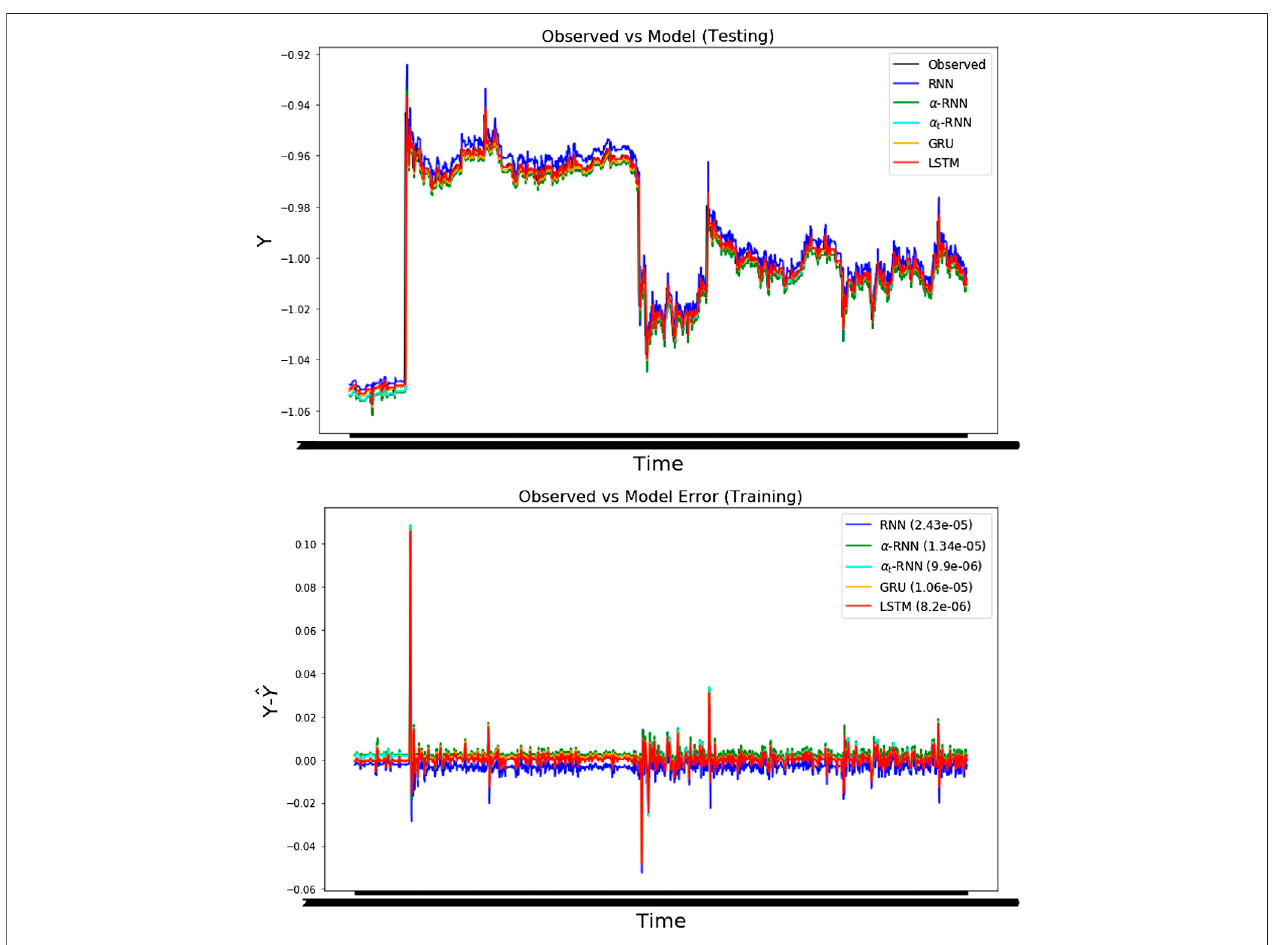
FIGURE3| Thefour-stepaheadforecastsoftemperatureusingtheminutesnapshotBitcoinprices(USD)withMSEsshowninparentheses.( top )Theforecastsfor each architecture and the observed out-of-sample time series. ( bottom ) The errors for each architecture over the same test period. Note that the prices have been standardized.